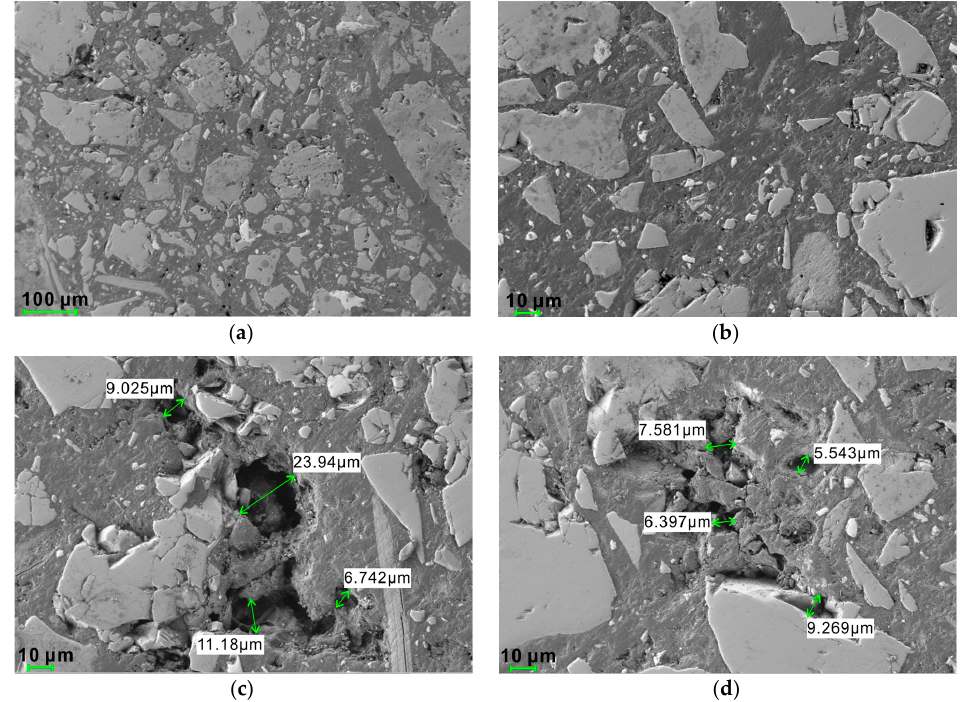
Figure 2. SEM images of the cemented tailings paste. Images ( a – d ) are at 129, 571, 620, and 667 times magnification, respectively). magnification,